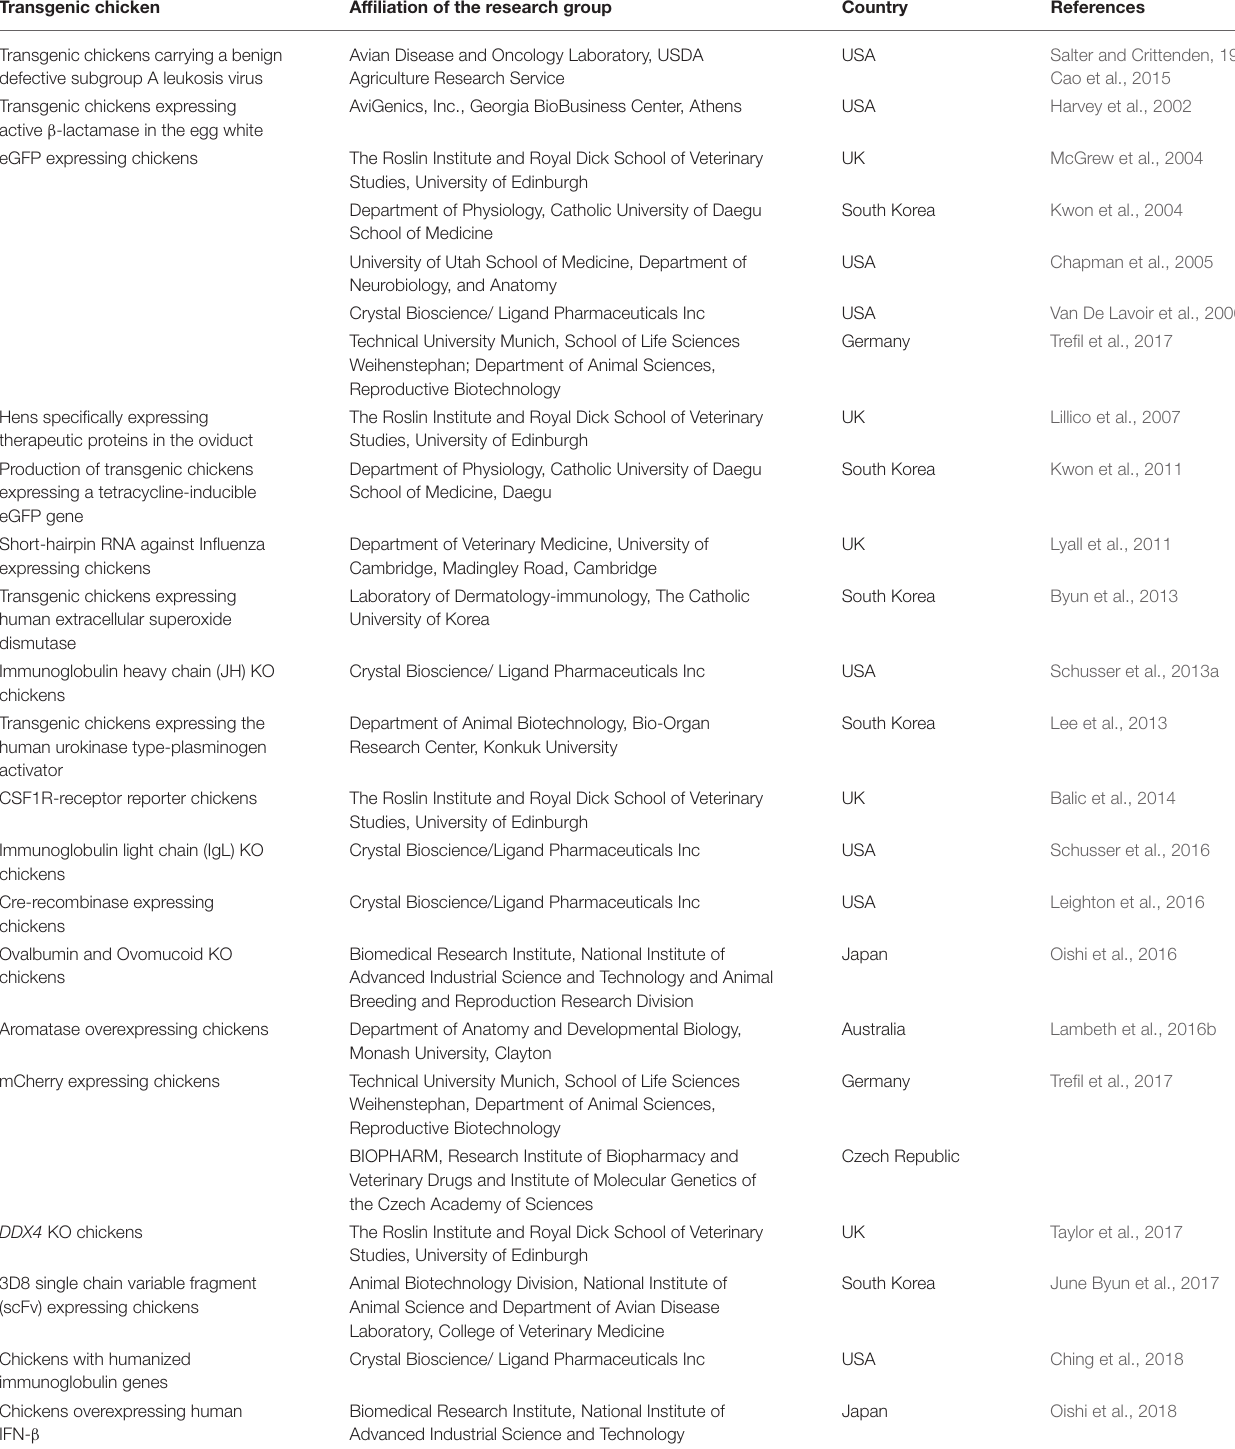
TABLE 2 | Worldwide availability of genetically modified